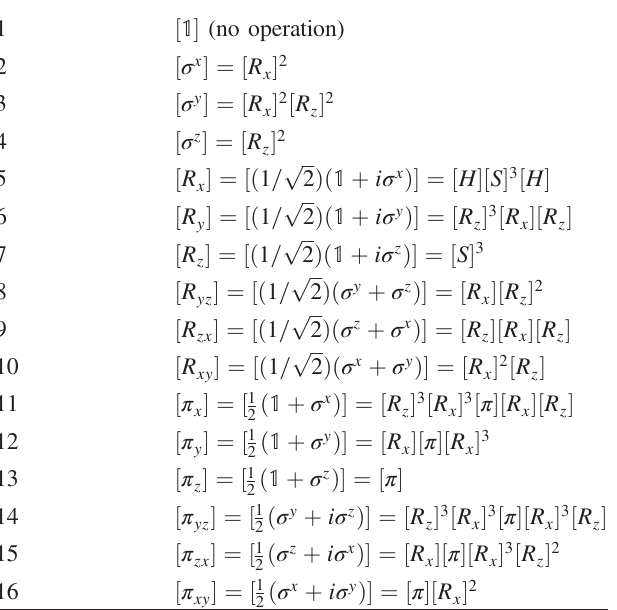
TABLE I. Sixteen basis operations. Gates ½ R derived from [ H ] and [ S ], and other operations can be derived from [ π ], ½ R , and ½ R x (cid:4) y (cid:4)